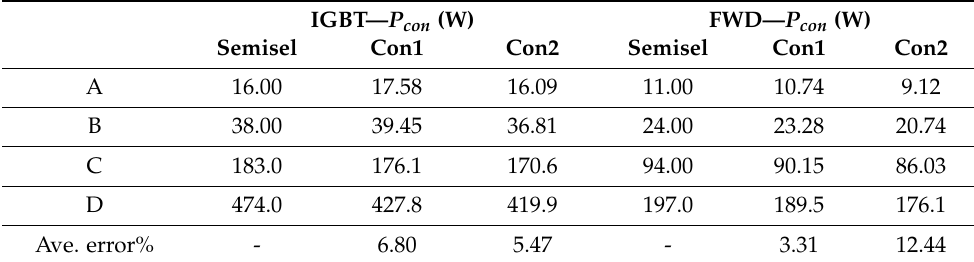
Table 12. Conduction losses comparison, V DC = 600 V.